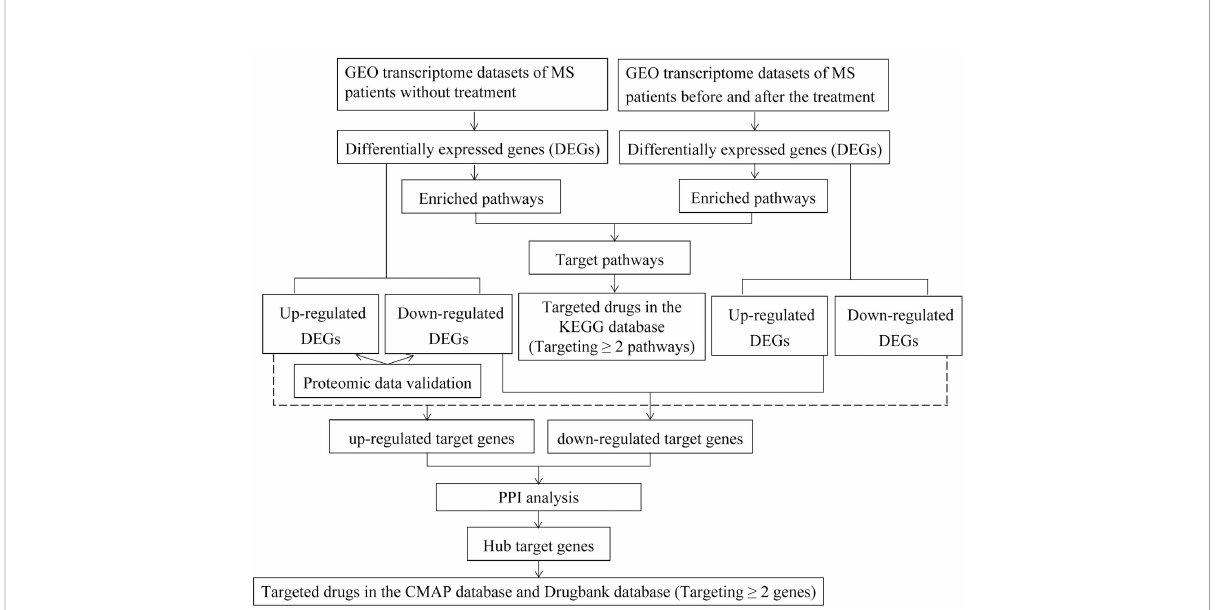
FIGURE 1 The work fl ow of the